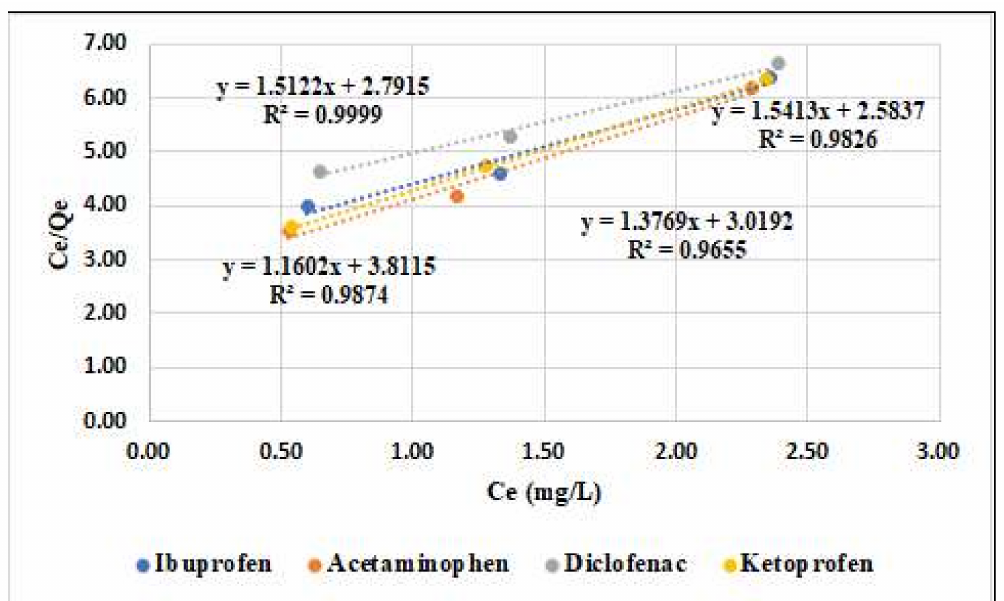
Figure 3. Langmuir linearized isotherm for ibuprofen, acetaminophen, diclofenac, and ketoprofen onto activated carbon.